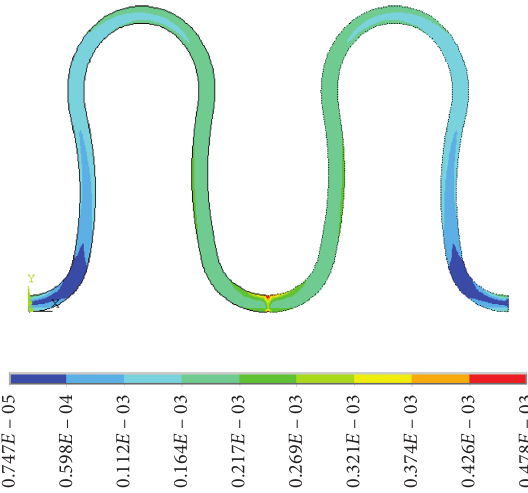
Figure 12: Strain distribution at air outlet and gas inlet side considering thermal stress.